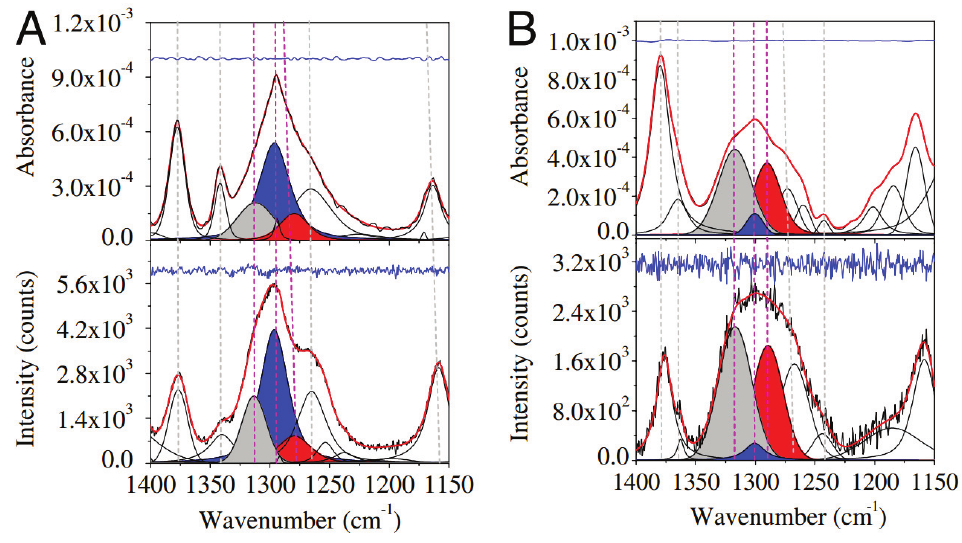
Figure 16. Experimental (black line) and fitted (red line) ATR-absorbance ( Upper ) and Raman ( Lower ) spectra (amide III region) for four dipeptides: ( A ), glycine; ( B ), arginine; ( C ), methionine; and ( D ), isoleucine. The three colored components are gray (band A) PII; blue (band B) (cid:7)R; red (band C) (cid:8). Taken from ref. [76] with